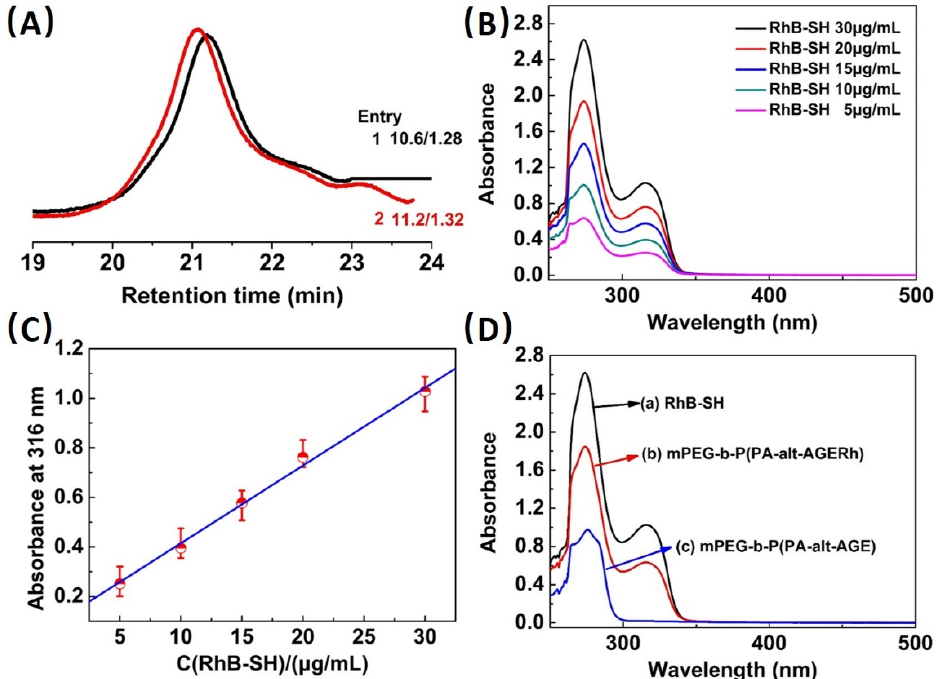
Figure 3. ( A ) SEC traces of mPEG- b -P(PA- alt -AGE) copolymer (black line) and rhodamine-functionalized mPEG- b -P(PA- alt -AGERh) copolymer (red line); ( B )UV–vis absorption for RhB-SH in DMF solution of different concentrations (30, 20, 15, 10 and 5 μ g/mL); ( C ) Plot of absorbance at 316 nm for RhB-SH in DMF solution of different concentrations; ( D ) Absorption spectra of (a) RhB-SH (0.03 mg/mL), (b) mPEG-b-P(PA-alt-AGERh) (0.083 mg/mL) and (c) mPEG-b-P(PA-alt-AGE) (0.53 mg/mL) in DMF solution.